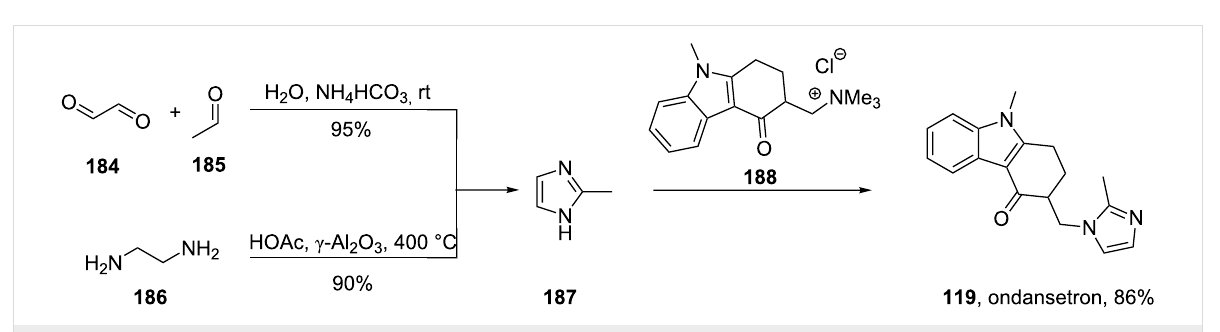
Scheme 36: Preparation of the imidazole ring in